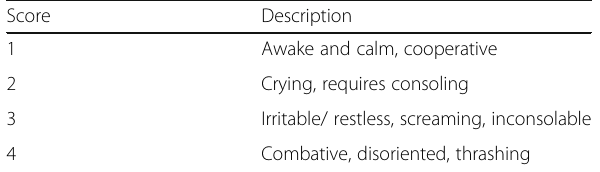
Table 5 Emergence Agitation Scale (Sikich & Lerman, 2004)